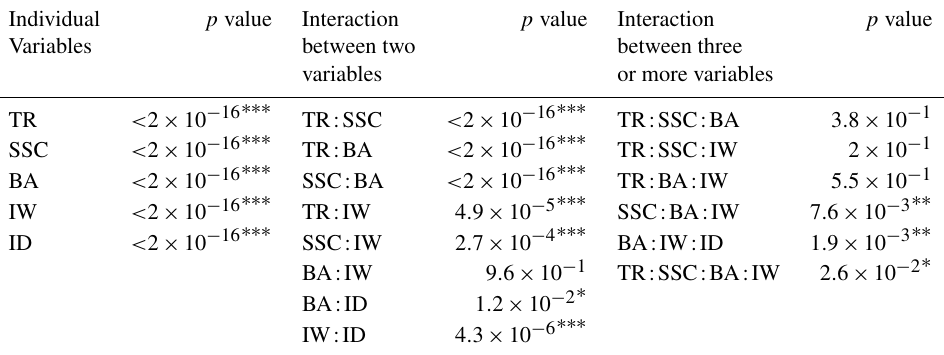
Table 3. ANOVA test p value for sediment deposition per day (SPD), with tidal range (TR), suspended sediment concentration (SSC), beel surface area (BA), width of the inlet (IW), and inundation depth (ID) and their interaction. Individual p value Interaction p value Interaction p value Variables between two between three variables or more variables ∗∗∗ ∗∗∗ TR < 2 × 10 − 16 TR : SSC < 2 × 10 − 16 TR : SSC : BA 3 . 8 × 10 − 1 ∗∗∗ ∗∗∗ SSC < 2 × 10 − 16 TR : BA < 2 × 10 − 16 TR : SSC : IW 2 × 10 − 1 ∗∗∗ ∗∗∗ BA < 2 × 10 − 16 SSC : BA < 2 × 10 − 16 TR : BA : IW